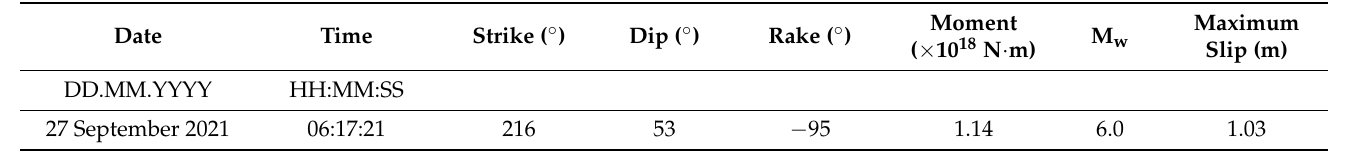
Figure 8. Modeled geodetic seismic fault for the 27 September 2021 earthquake in 3-D illustration ( a ) and in vertical profile along SW-NE strike ( b ). Table 3. Seismic source solution for the 27 September 2021 earthquake determined from InSAR